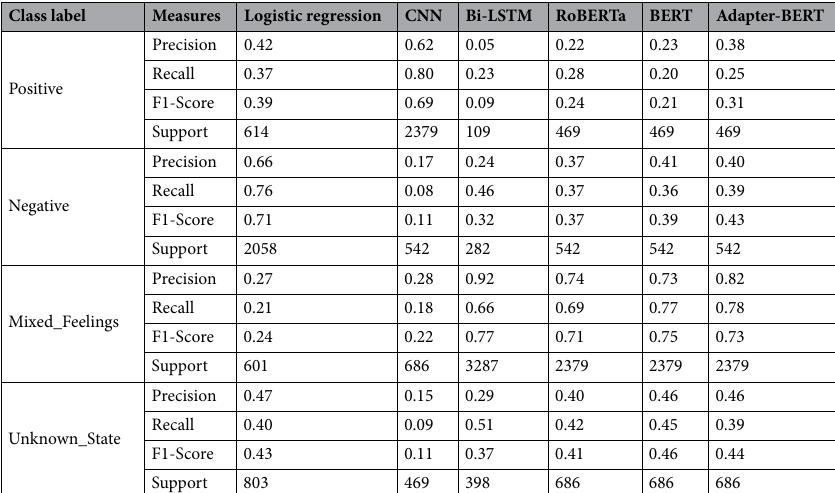
Table 4. Classification report of different models for sentiment